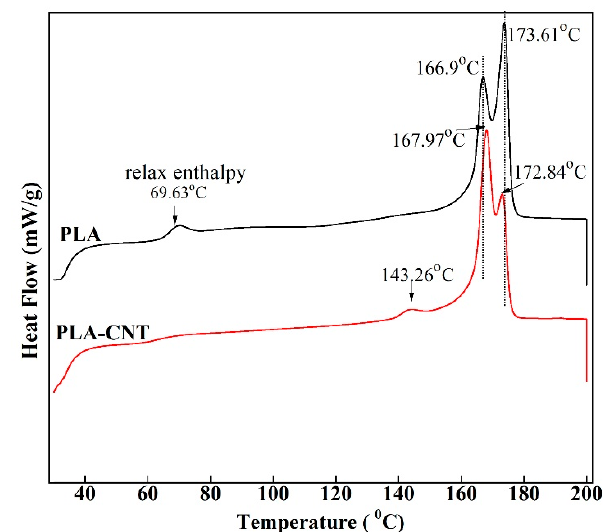
Figure 4. First heating differential scanning calorimetry (DSC) thermograms of PLA and PLA-CNT after isothermal crystallization.